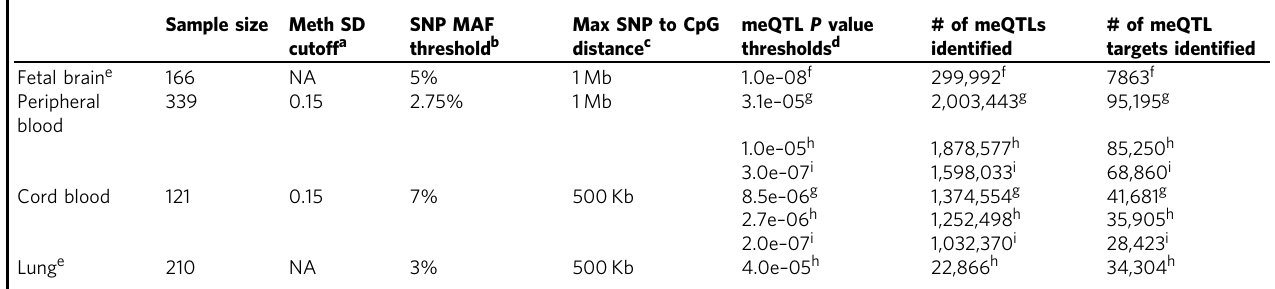
Table 1 Descriptive characteristics, meQTL query parameters, and meQTL summary results for four tissues